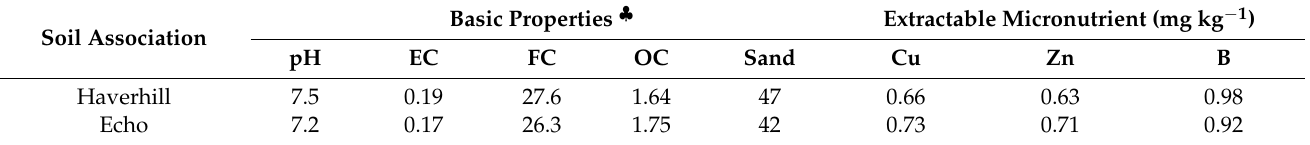
Table 1. Summary of spring 2015 baseline soil properties (0–15 cm depth) from Haverhill and Echo site